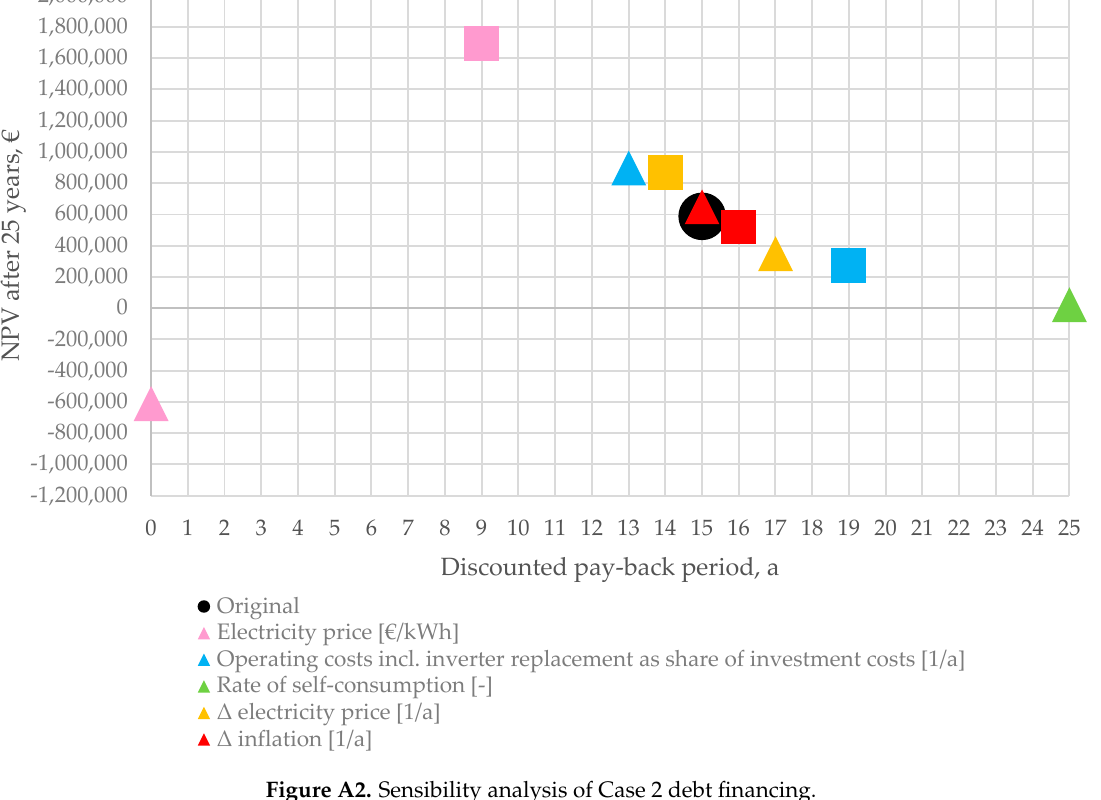
Figure A2. Sensibility analysis of Case 2 debt financing.